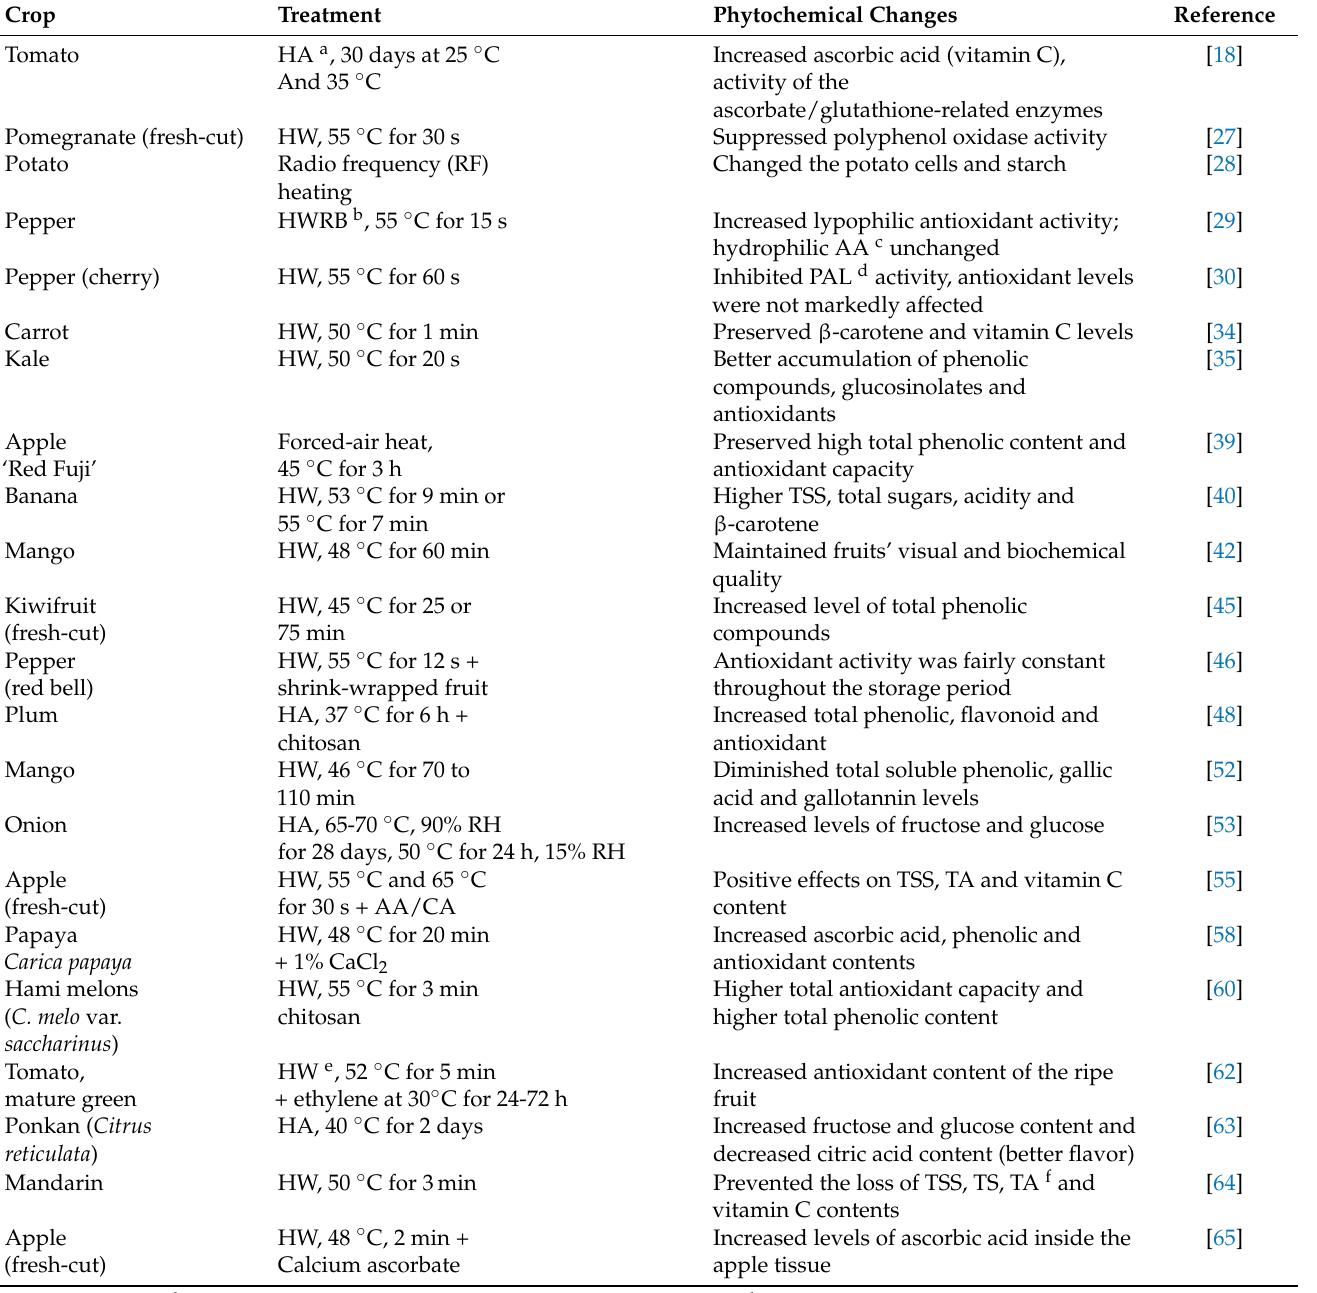
Table 1. Different heat treatments that alone and in combination with other treatments affect phytochemicals in fresh and fresh-cut produce during